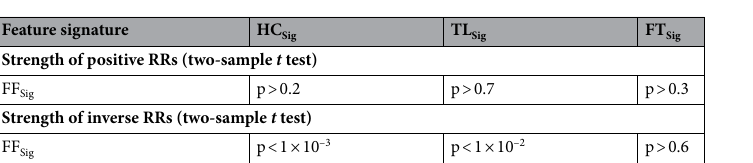
Table 1. Two-sample t tests that assess the strengths of all RRs constructed using the FF Sig with HC Sig , TL Sig and FT Sig , in both statistical directions on the NRG-H